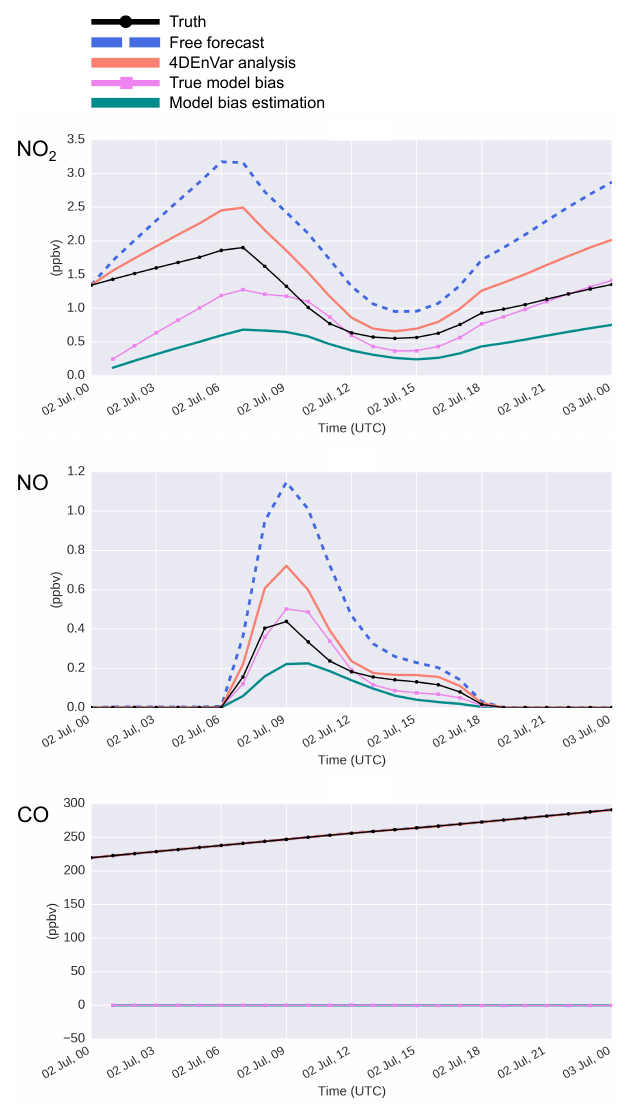
Figure 10. Multivariate effective model error estimation. Temporal trajectories for day 2, as in Fig. 8 but for NO 2 , NO and CO species (not assimilated), obtained assimilating only O 3 . Uncertainties were both in the O 3 initial condition and in the forecast model (NO emis- sions), corresponding to the third experiment in Fig. 8. Only differ- ence with the previous experiment in is that a non-zero multivariate localization coefficient is used